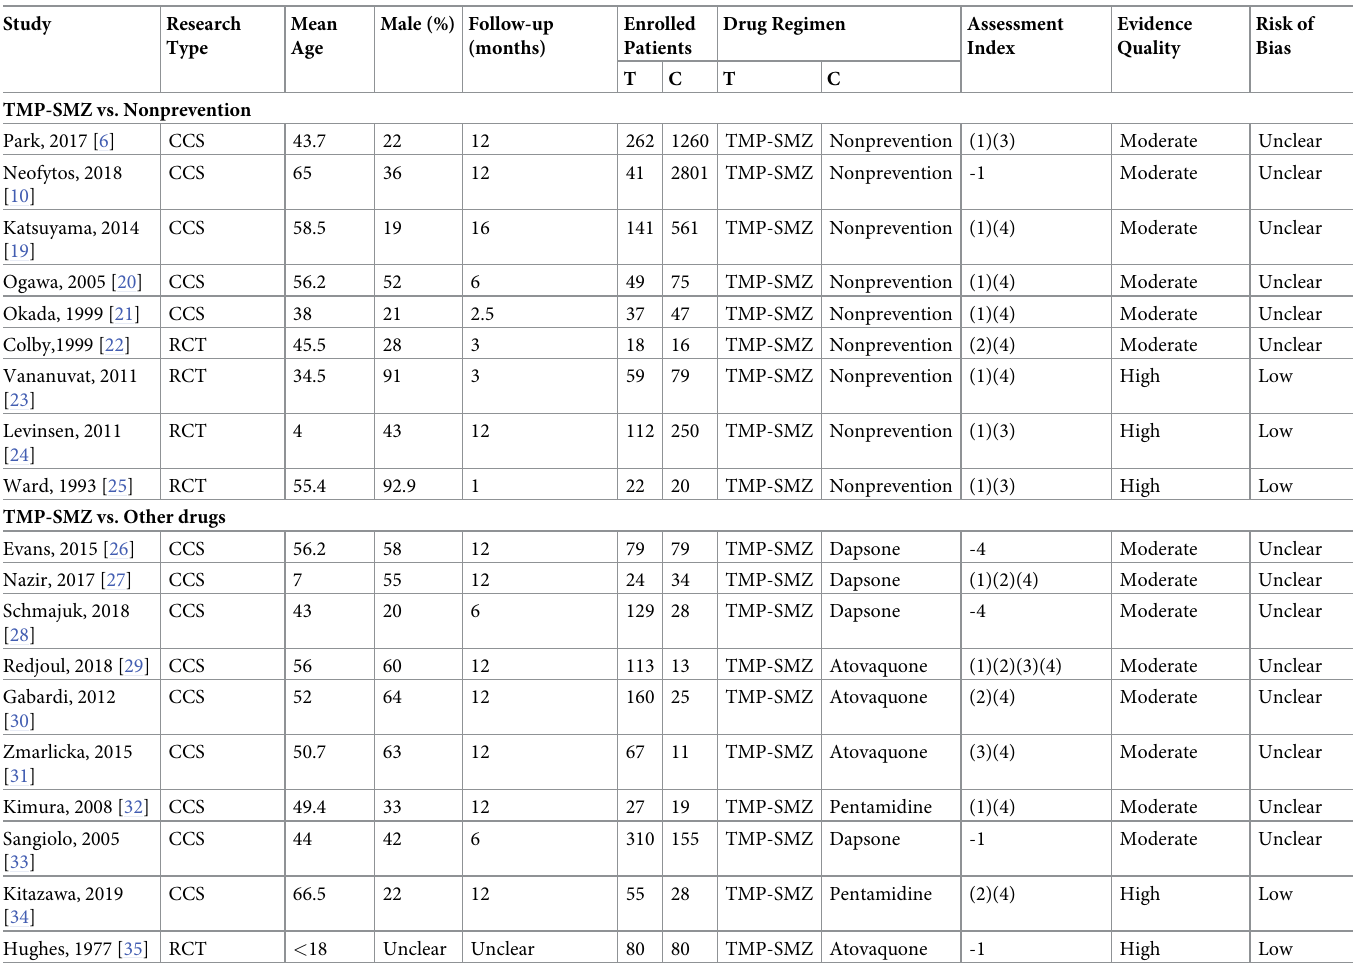
Table 1. Main characteristics of the studies included in the